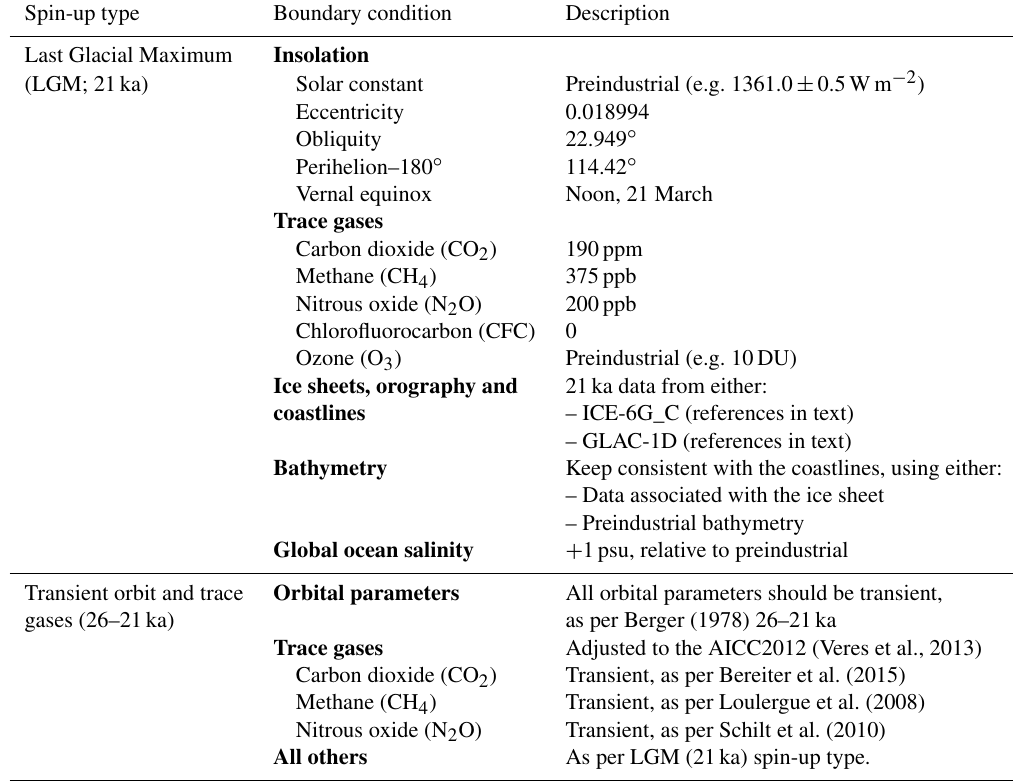
Table 1. Summary of recommended model boundary conditions to spin-up the last deglaciation Core experiment version 1 (pre 21ka); see text for details. Participants are not required to follow the recommendation for these boundary conditions, but must document the method used, including information on the simulation’s state of spin-up at the point when the Core is started. Data are available from PMIP4 last deglaciation wiki (PMIP Last Deglaciation Working Group, 2016). Boundary condition group headings are in